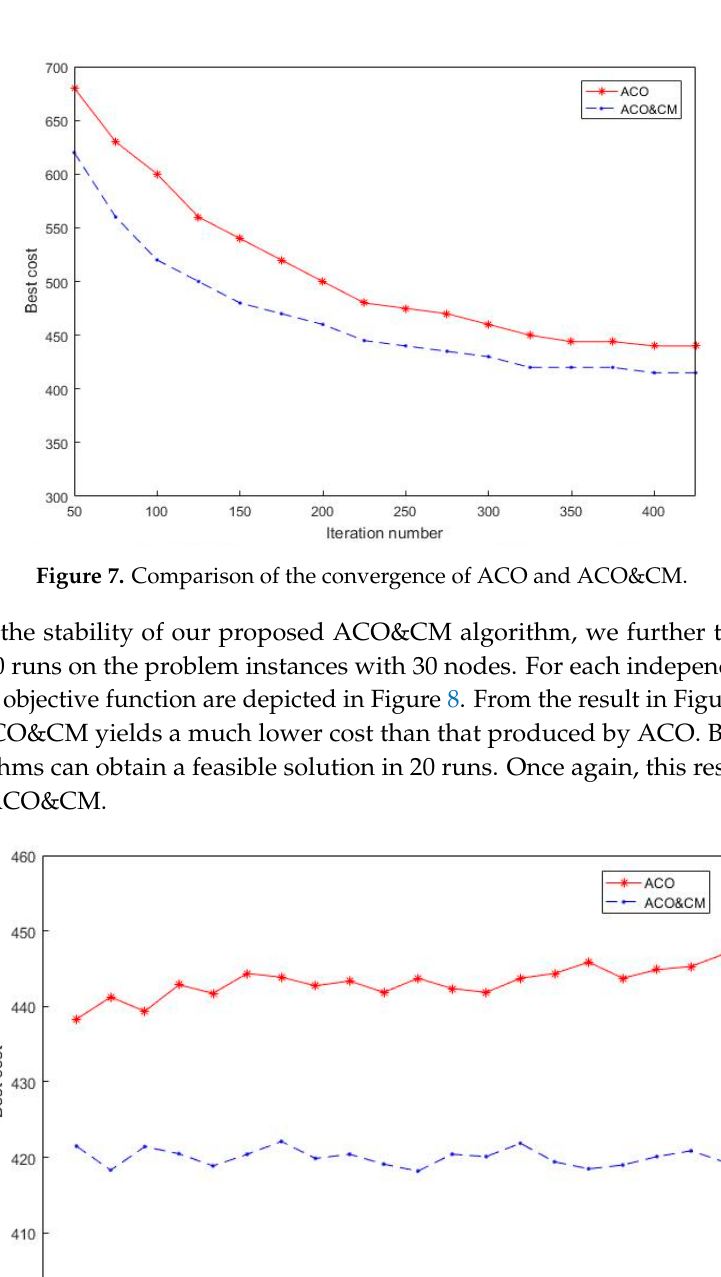
Figure 6. A test network topology. To investigate the convergence properties of ACO and ACO&CM algorithms, we test their convergence performance on the 30 nodes. Due to publishing space restrictions, we only provide the